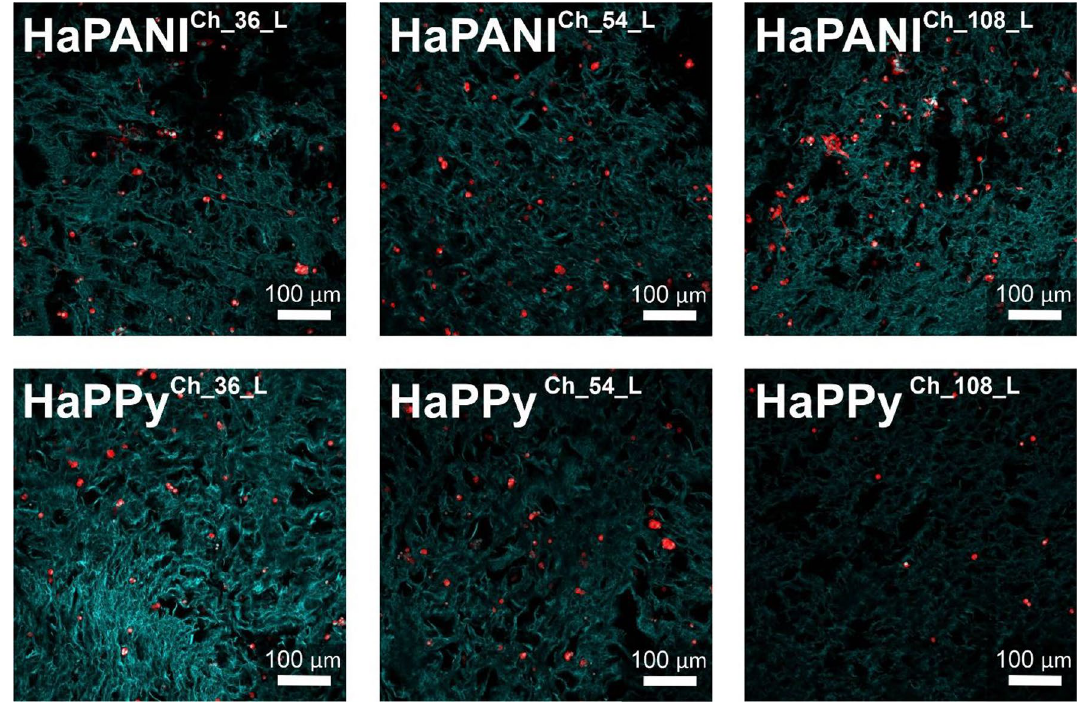
Figure 9. The adhesion and growth of cells on the surface of scaffolds. Cell nuclei were counterstained with Hoechst (blue); the cytoskeleton was counterstained with ActinRed (red). The green colour represents the hydrogel